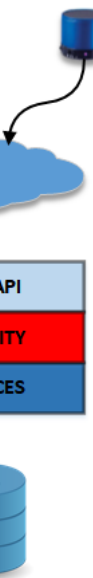
Figure 3. The cloud architecture of the AuDi-o-Mentia system and its